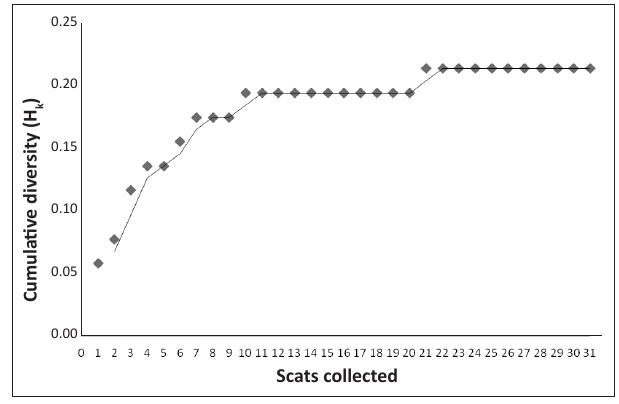
n = 31 scats. FIGURE 3: Species accumulation curve based on the cumulative Brillouin index for brown hyaena scat samples in Shamwari Game Reserve, Eastern Cape Province, South Africa.